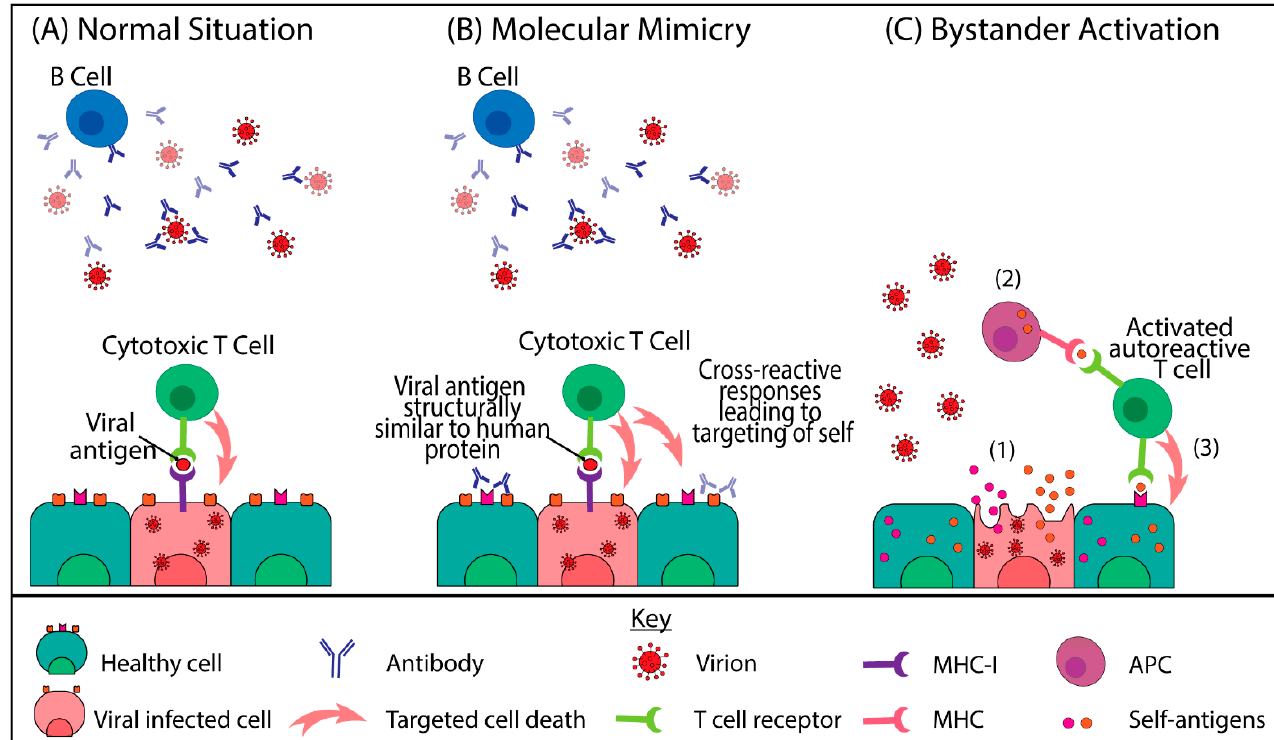
Figure 1. Mechanisms of virally induced autoimmunity. ( A ) In the normal situation, B cells will release antibodies upon activation that can bind to the extracellular virus [27]. Infected cells will present viral antigens on MHC class 1 (MHC-I) to cytotoxic T cells, resulting in the activation of the T cells and killing of these virus-infected cells [28]. ( B ) Molecular mimicry occurs when the viral antigen is structurally similar to human-derived proteins [26]. Antibodies may bind to both viruses and self-proteins (e.g., on healthy cell surfaces). T cells may become activated by the viral protein and target a virus-infected cell but also recognise and attack self. ( C ) Bystander activation. (1) Release of self-antigens into an inflammatory environment. (2) Antigen uptake and presentation by an antigen presenting cell (APC) to an autoreactive T cell. (3) Activated autoreactive T cell recognises and attacks healthy cells.